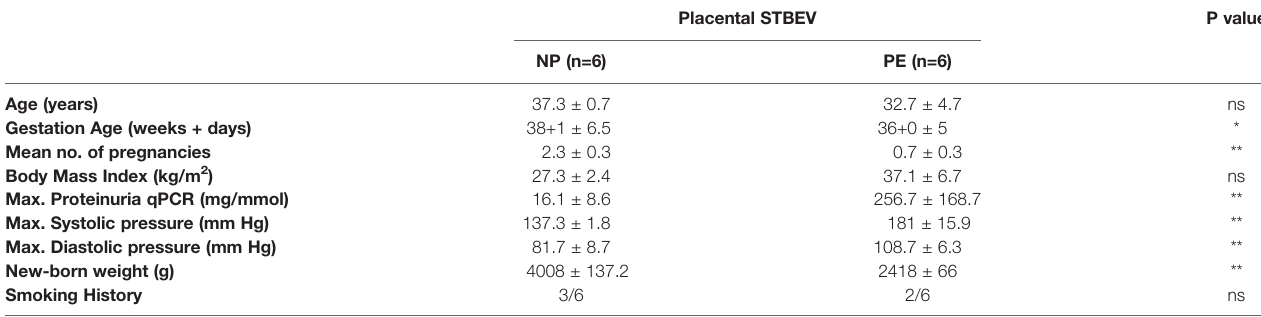
TABLE 1 | Clinical data of human subjects.